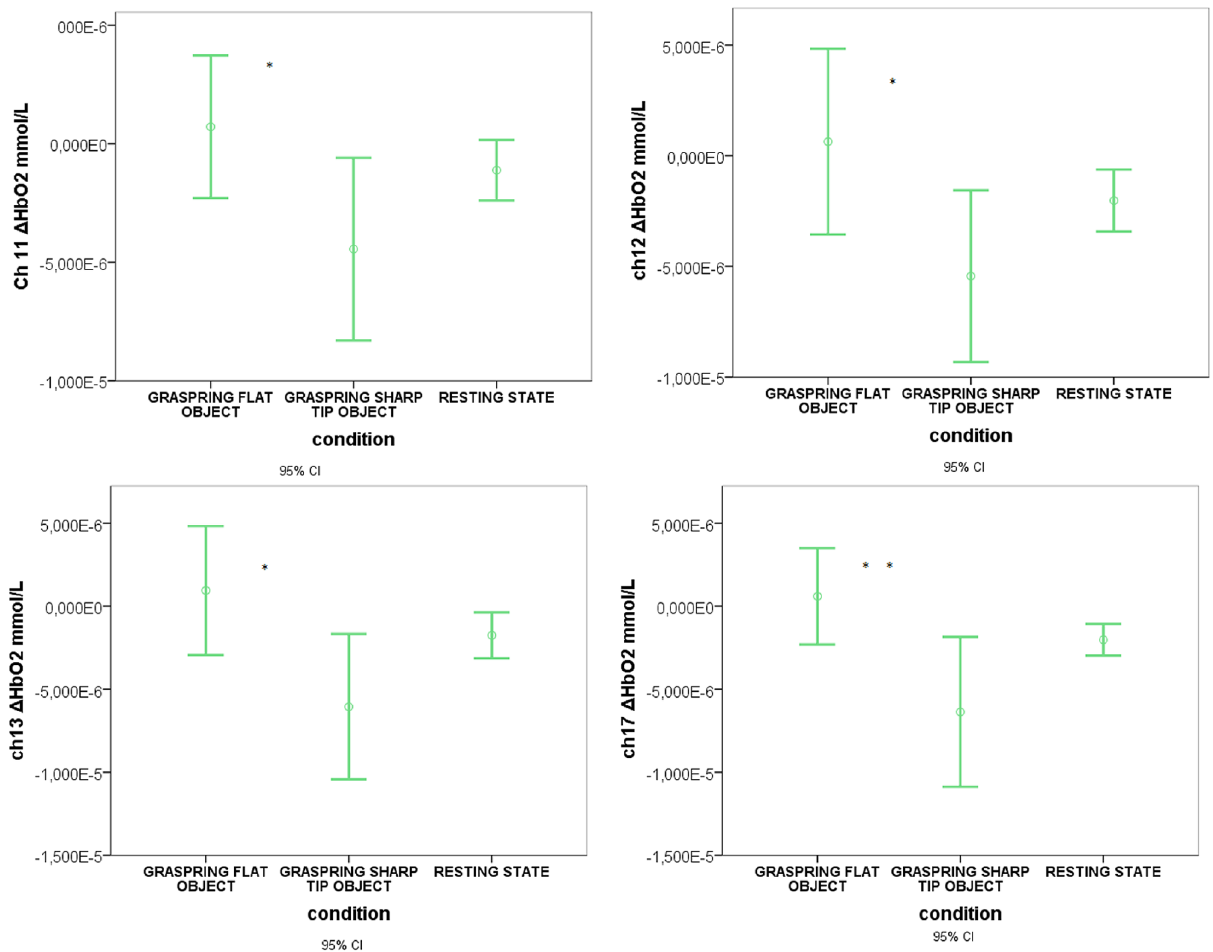
Figure 10. Mean and 95% CI of oxyhemoglobin levels recorded during the Time-to-contact detection session in FM patients. The results of Bonferroni tests are reported. Comparison between conditions Grasping Flat versus Grasping Sharp-tip object: * p < 0.05; ** p < 0.001. The oxyhemoglobin level was significantly lower during sharp-tip object trials than during flat object trials. The comparisons with the Resting State did not reach the statistical significance, so the main phenomenon we observed was the contrast between cortical activation modality in grasping flat vs grasping sharp-tip object.